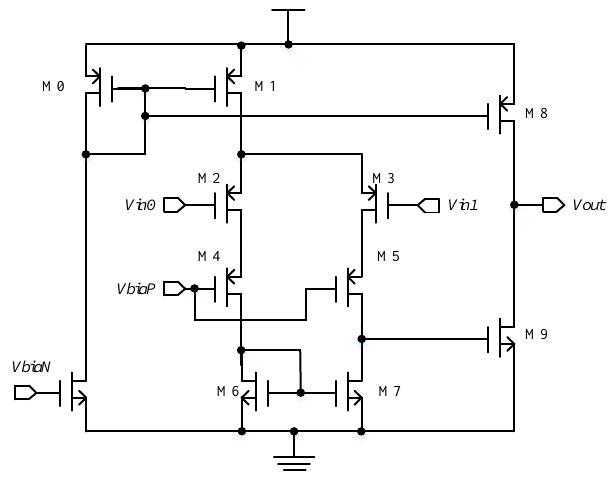
Figure 4. Operational amplifier circuit.